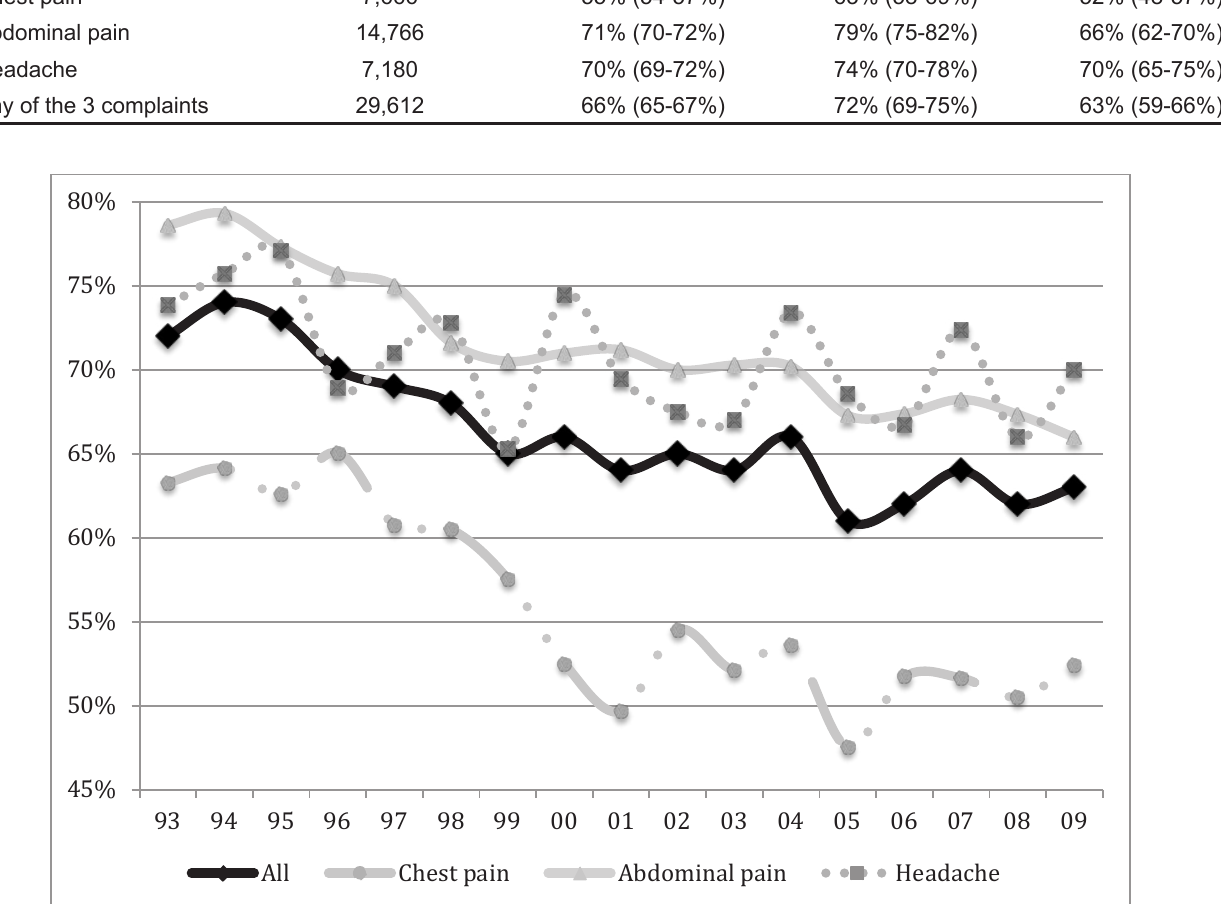
Headache Figure. Proportion of emergency department patients discharged with pathological discharge diagnosis for three most common chief